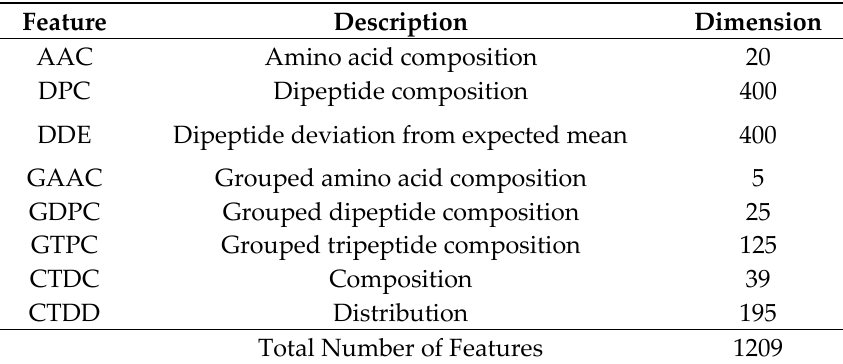
Table 1. List of peptide features.